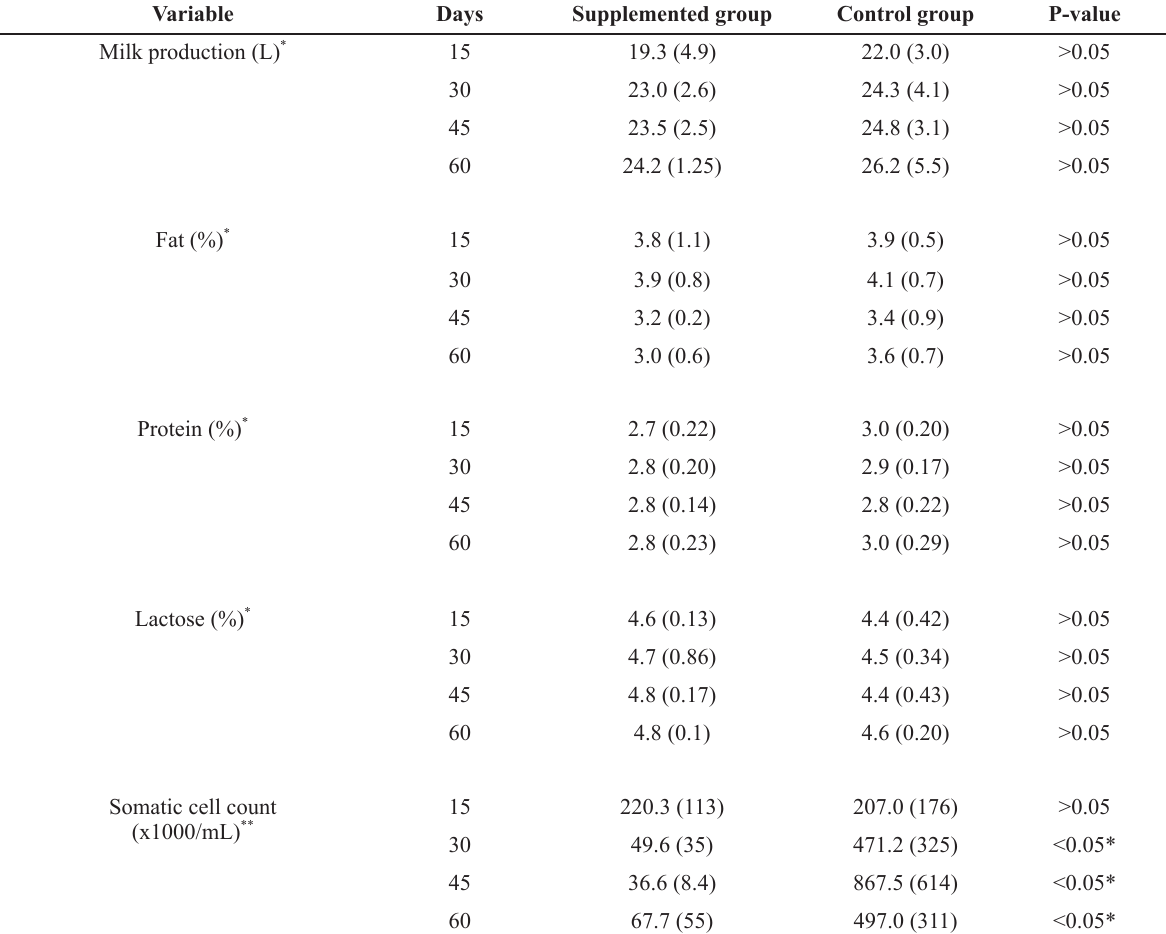
Mean and standard deviation of milk production, milk composition and somatic cell counts on days 15, 30, 45 and 60 post-calving of dairy primiparous cows supplemented with injectable minerals during the transitional